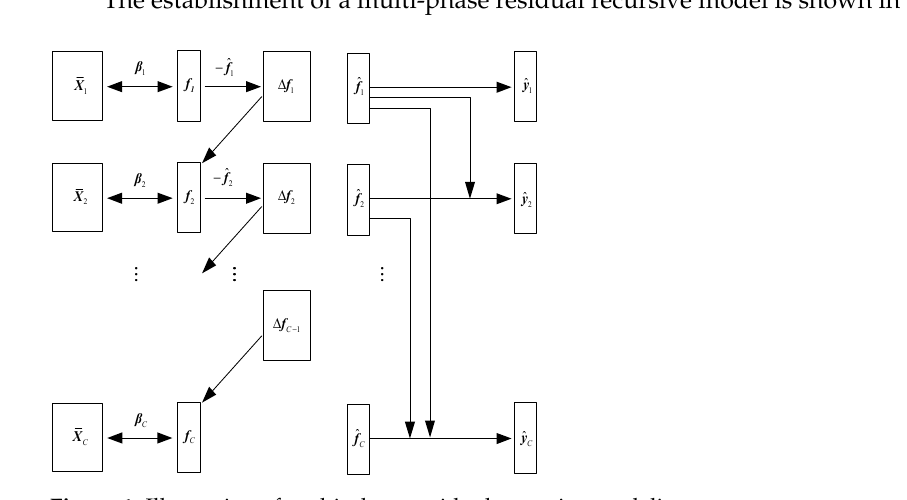
Figure 1. Illustration of multi-phase residual recursive modeling.